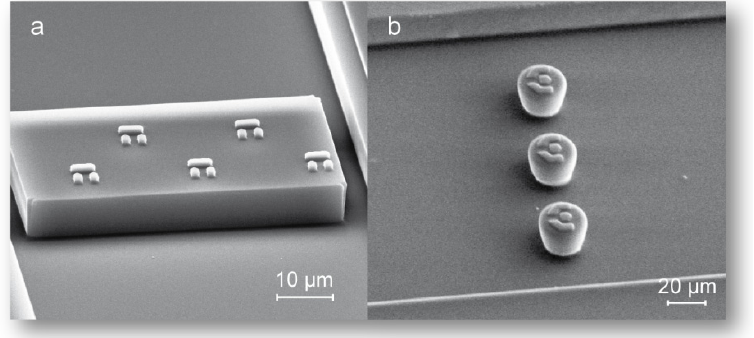
Figure 2. ( a ) SEM image of single-cell trapping structures with partially reduced trapping area. ( b ) SEM image of final trapping